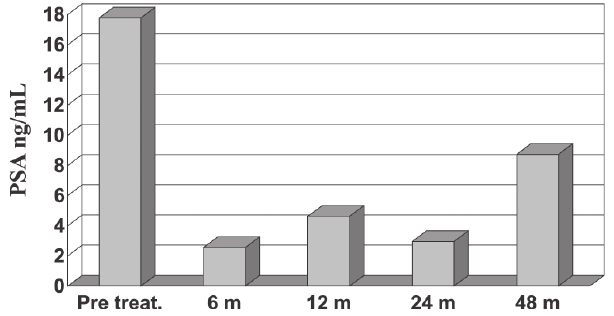
Figure 2 – PSA values in 21 high-risk prostate cancer patients after 6, 12, 24, and 48 months of treatment with